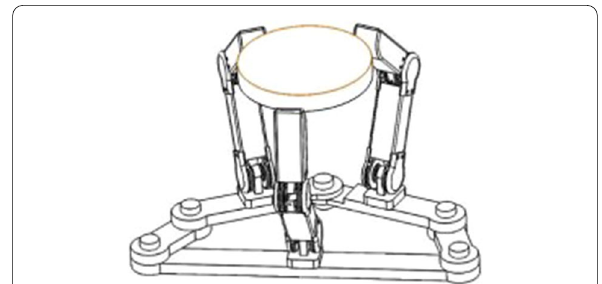
Figure 2 Novel metamorphic multi-fingered hand grasping a disk